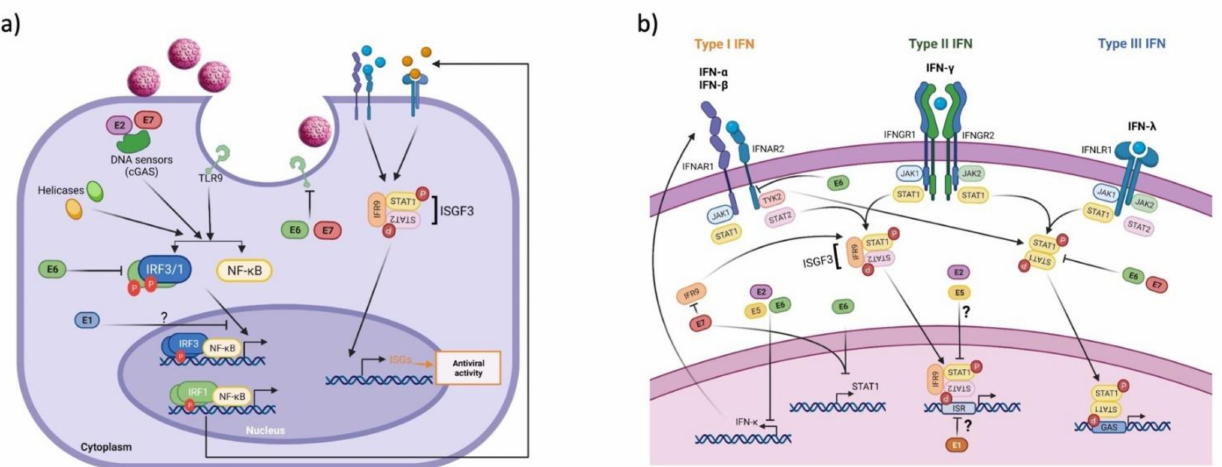
Figure 3. Effect of HPV proteins on IFN production and the ISG pathway. When the cell senses viral DNA, signaling pathways are triggered to produce IFN; then, the binding of IFN to its receptors activates the ISG pathway to control viral infection. ( a ) HPV proteins affect IFN production: E6 and E7 oncoproteins interact with TLR and cGAS receptors and also with transcriptional factors such as IRF-3 and -1 that block IFN production. In addition, E1 protein prevents the expression of IFN- β and IFN- λ ; however, the mechanisms of such regulation are still unclear. ( b ) The production of IFN promotes the activation of the ISG pathway; however, HPV proteins prevent its activation by acting at various levels of regulation of the pathway. However, it is not known if the inhibition of IFN is enough to prevent the activation of ISGs or whether other components such as STAT1 and STAT2 could be regulated by these proteins. IFN, interferon; IFNAR, IFN- α receptor; IFNGR, IFN- γ receptor; IFNLR, IFN- λ receptor; IRF9, interferon regulatory factor 9; ISGF3, interferon stimulated gene factor 3; ISRE, interferon stimulated response element; GAS, gamma interferon activation site. Figure created using